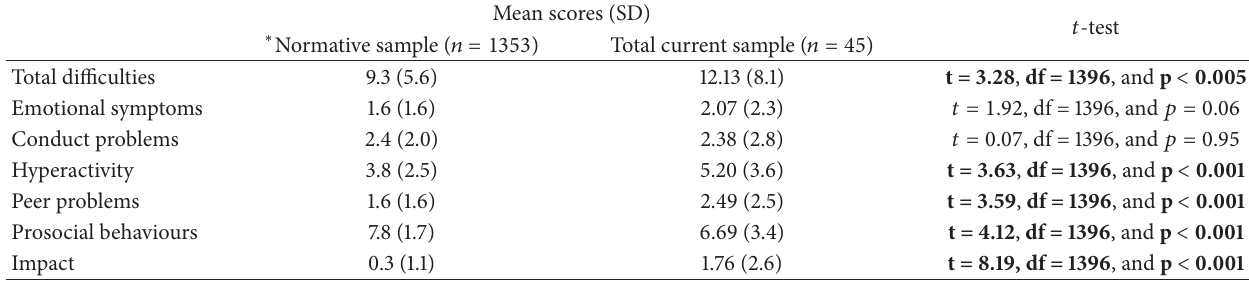
Table 4: Comparing SDQ scores between our sample and a normative sample.